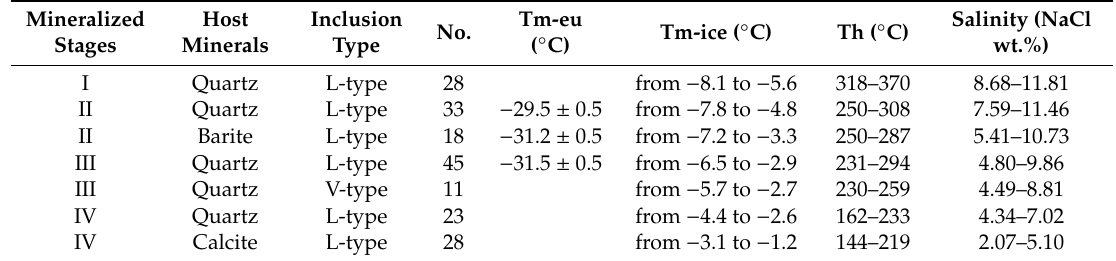
Table 1. Microthermometric data and relative parameters of fluid